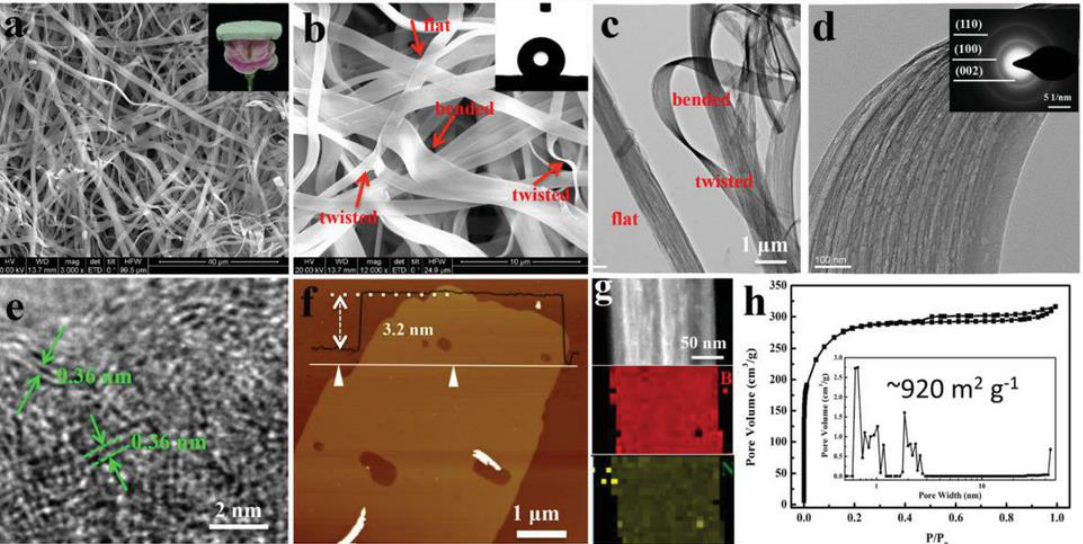
Figure 12. BN nanofibers: ( a , b ) SEM images, ( c – e ) TEM images, ( f ) an AFM image of BN nanoribbon aerogel, ( g ) STEM and element mappings of single BN nanoribbon, and ( h ) nitrogen adsorption – desorption isotherms of BN nanoribbon aerogels. Inset in ( a ), a BN nanoribbon aerogel monolith was placed on a flower. Inset in ( b ), the contact angle of BN aerogel. Inset in ( d ), the corresponding electron diffraction pattern. Inset in ( h ), the corresponding pore size distribution curve. (Reprinted with permission from Ref. [30]. 2019 WILEY-VCH Verlag GmbH & Co,. KGaA.)